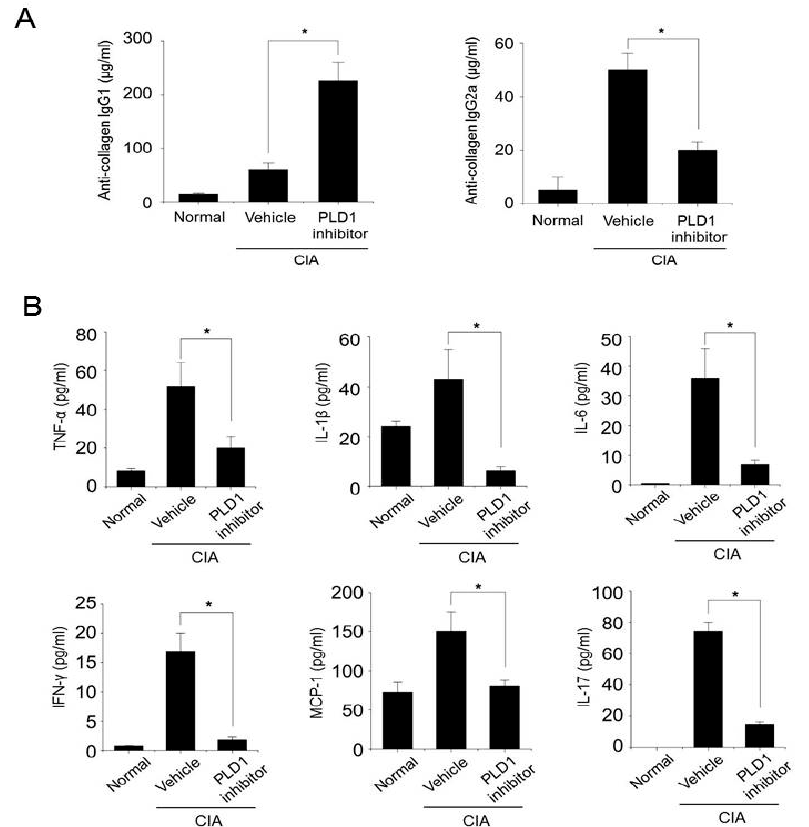
Figure 5. The PLD1 inhibitor reduces the production of the anti-CII IgG2a autoantibody and proinflammatory cytokines in collagen-induced arthritis (CIA) mice. ( A ) The amount of anti-collagen IgG1 and IgG2a antibodies was measured by ELISA in the serum of the indicated mice at day 45. ( B ) The amount of proinflammatory cytokines was measured by ELISA in the serum of the indicated mice at day 45. n = 15 per group. * p < 0.05. Results are shown as mean ± standard error of the mean (SEM).